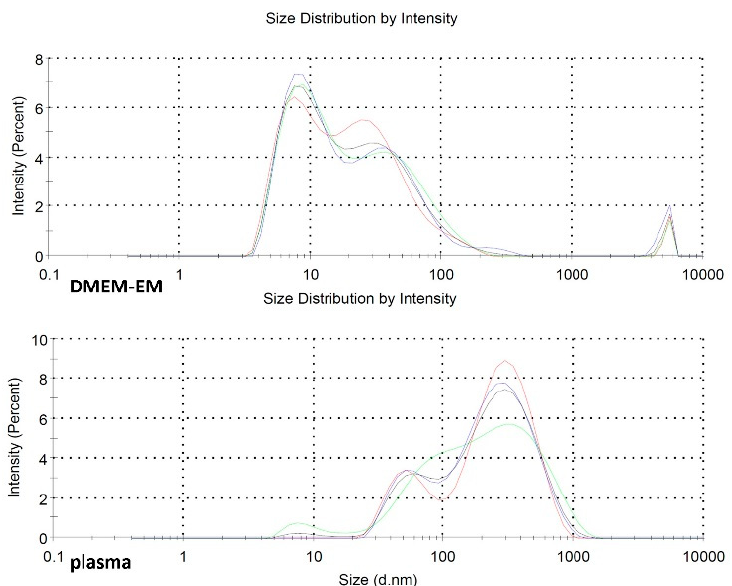
Figure 3. ZnO-nanoparticle (NP) characterization. The dispersion was analyzed by DLS. The sizes of ZnO-NPs in plasma and DMEM-EM were evaluated. In both groups, high variations in agglomerate size could be detected.